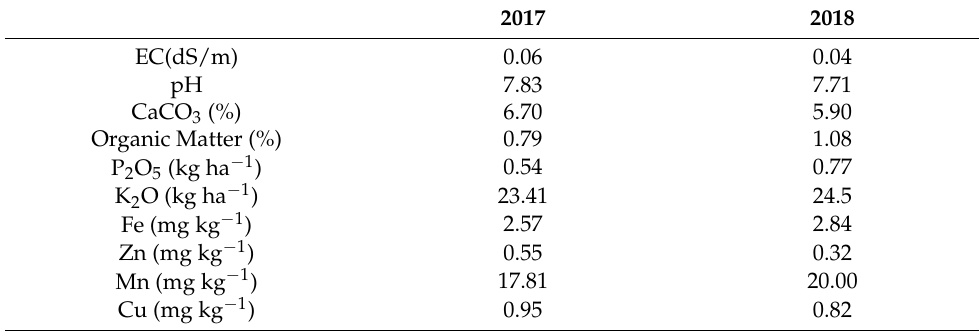
Table 1. Soil characteristics of the research area in 2017 and 2018.